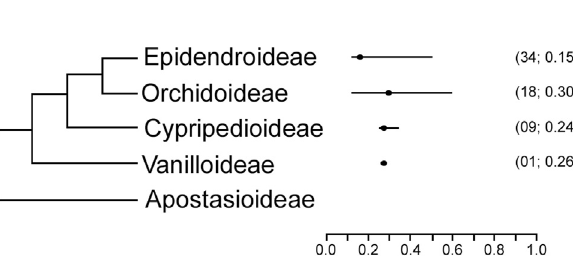
(Figure S1). Ask% and A indexes presented identical trees 1 (Figure S2) in the cluster analysis, with most species grouped with ideal karyotype B, plus a clade, separated into two groups: (1) a polytomy with the ideal karyotypes D, E and F and (2) a group with Christensonella pachyphylla , C.